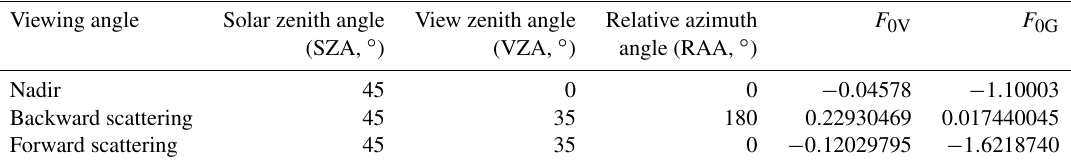
Table 2. Viewing angle normalizations and corresponding BRDF kernel